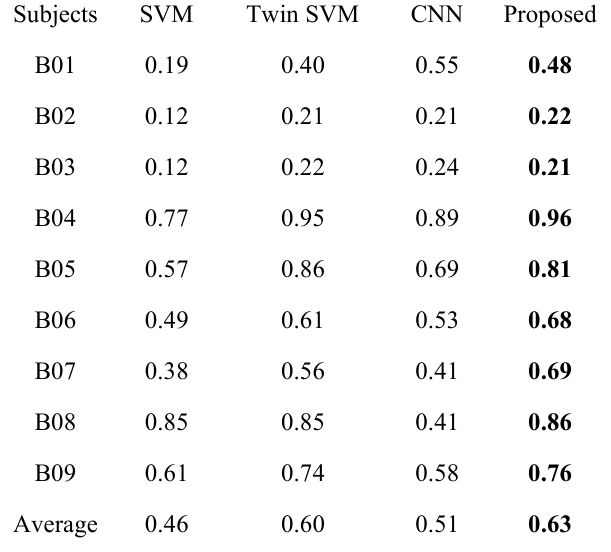
Table 2. kappa value comparison with